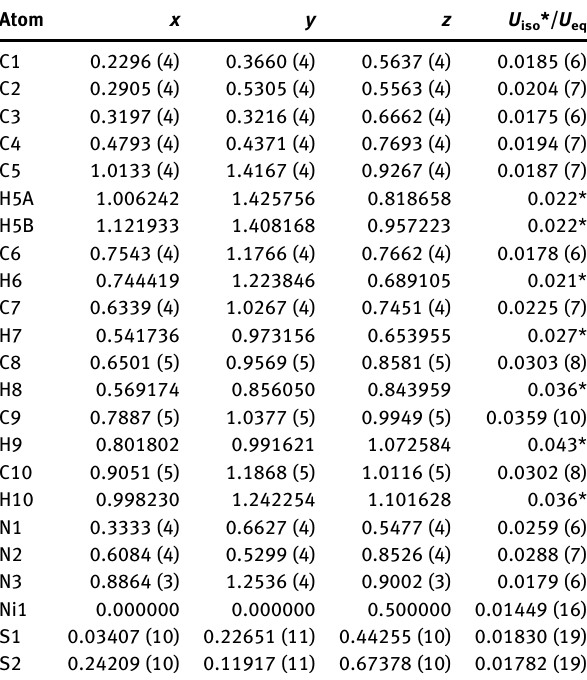
Table  : Fractional atomic coordinates and isotropic or equivalent isotropic displacement parameters (Å 